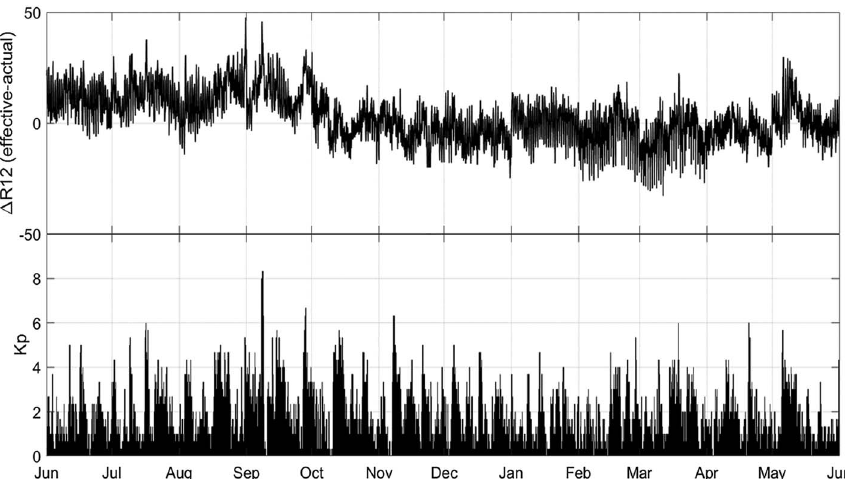
Fig. 8. Difference between R12eff and actual R12 from June 2017 to May 2018 (top panel). The Kp index for the same period is reported in the bottom